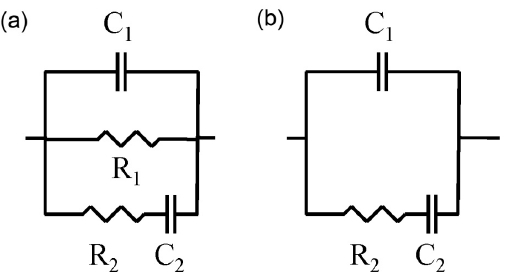
Figure 1. ( a ) Equivalent circuit used for the fitting of the impedance spectra obtained using the contacting method [42]; ( b ) Equivalent circuit used for the fitting of the impedance spectra obtained using the non-contacting method [42].